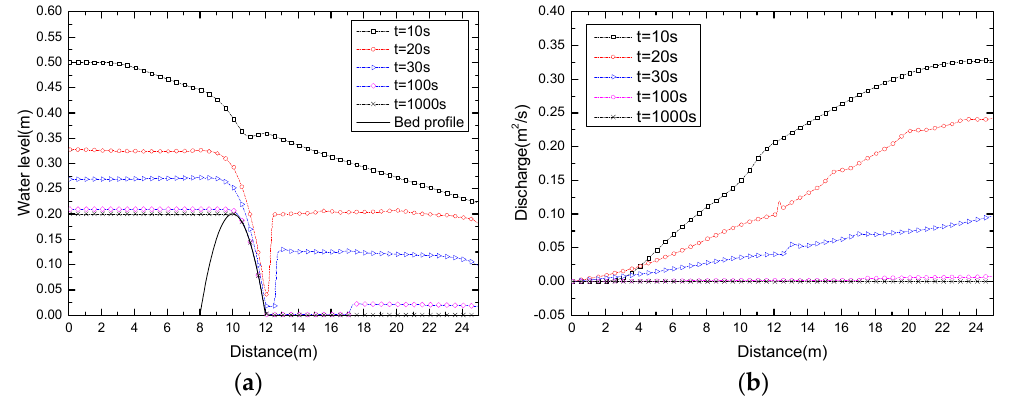
Figure 12. Drain on a bump bottom at different times: ( a ) the water level; ( b ) the discharge.